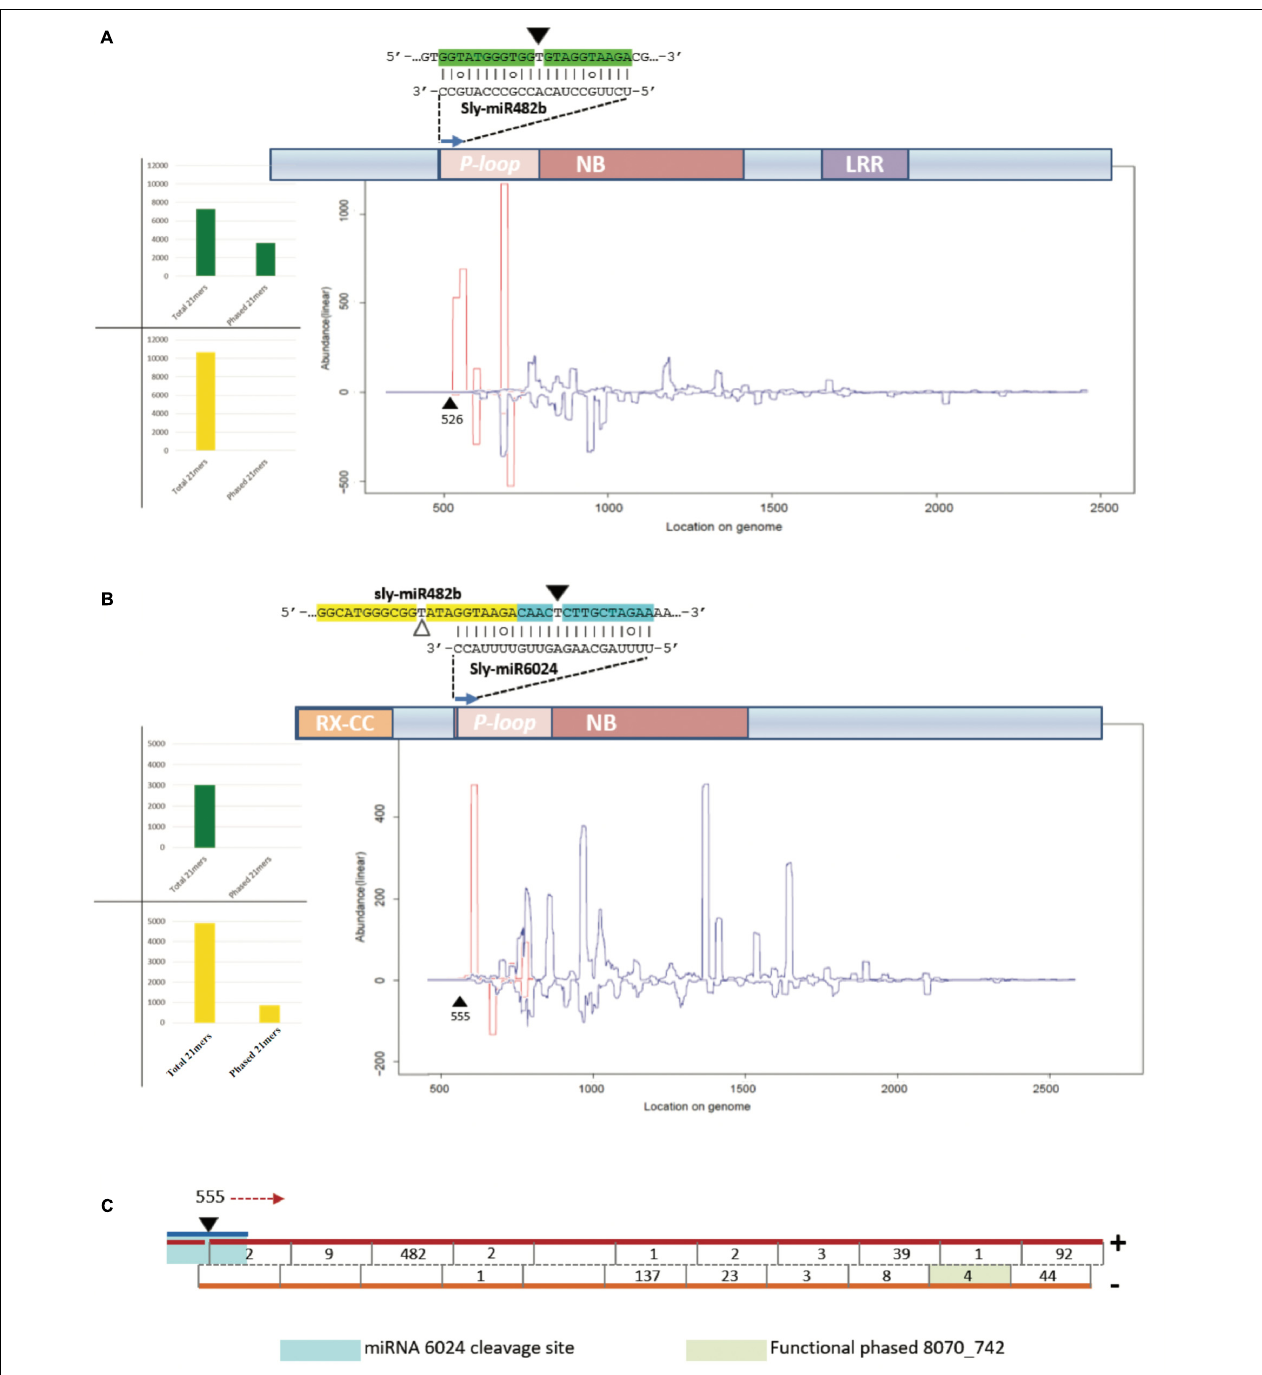
FIGURE 6 | Secondary siRNAs initiated by miRNAs. (A) Secondary siRNAs initiated by miR482 on Solyc02g036270 mRNA in mock-inoculated plant tissues; (B) secondary siRNAs initiated by miR6024 on Solyc008070 mRNA in TYLCSV-infected plant tissues; (C) and portion of Solyc05g008070 that is recognized as a source of phased secondary siRNAs. In (A,B) graphics of NBS–LRR genes are shown, which include conserved domains P-loop, nucleotide binding site (NBS), leucine-rich repeat (LRR), and RX-coiled-coil (RX-CC). In the graphic below the transcripts are indicated siRNAs of 21 nt in length, starting from the miRNA cleavage site (black triangle). White triangles indicate uncleaved miRNA target sites. Red and blue lines represent the abundance of each nucleotide position of phased and unphased 21mers, respectively. Histograms in (A,B) show total numbers of phased and unphased 21mers mapping to each gene locus in mock-inoculated (green) and virus-infected (yellow) plant tissues. In (C) , the blue line indicates miR6024, the black triangle the cleavage site in position 555, and red arrow indicates the direction of precursor processing into phased secondary siRNAs which are indicated by a black line in the double-stranded red/orange precursors. Numbers indicate abundance of each phased siRNA in the